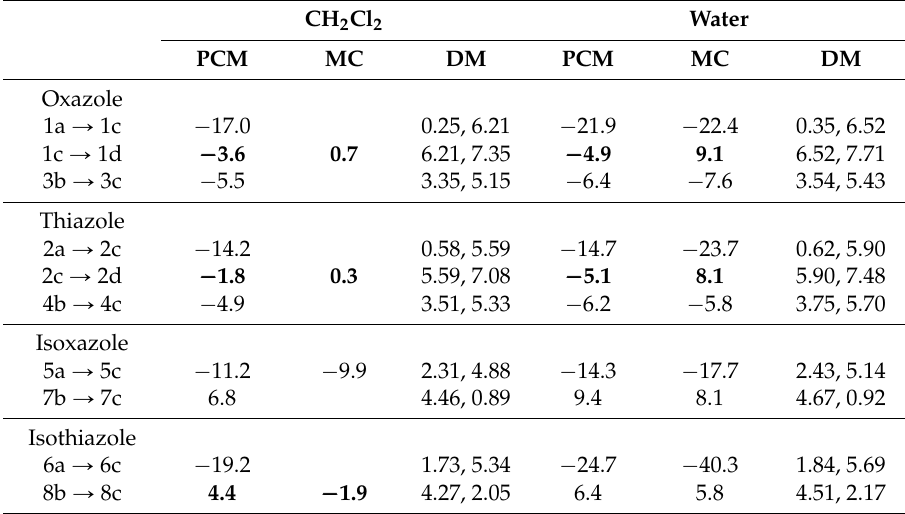
Table 4. Comparison of the relative solvation-free energies from IEF-PCM and Monte Carlo calculations. Corresponding dipole moments are indicated a . CH 2 Cl 2 Water PCM MC DM PCM Oxazole ´